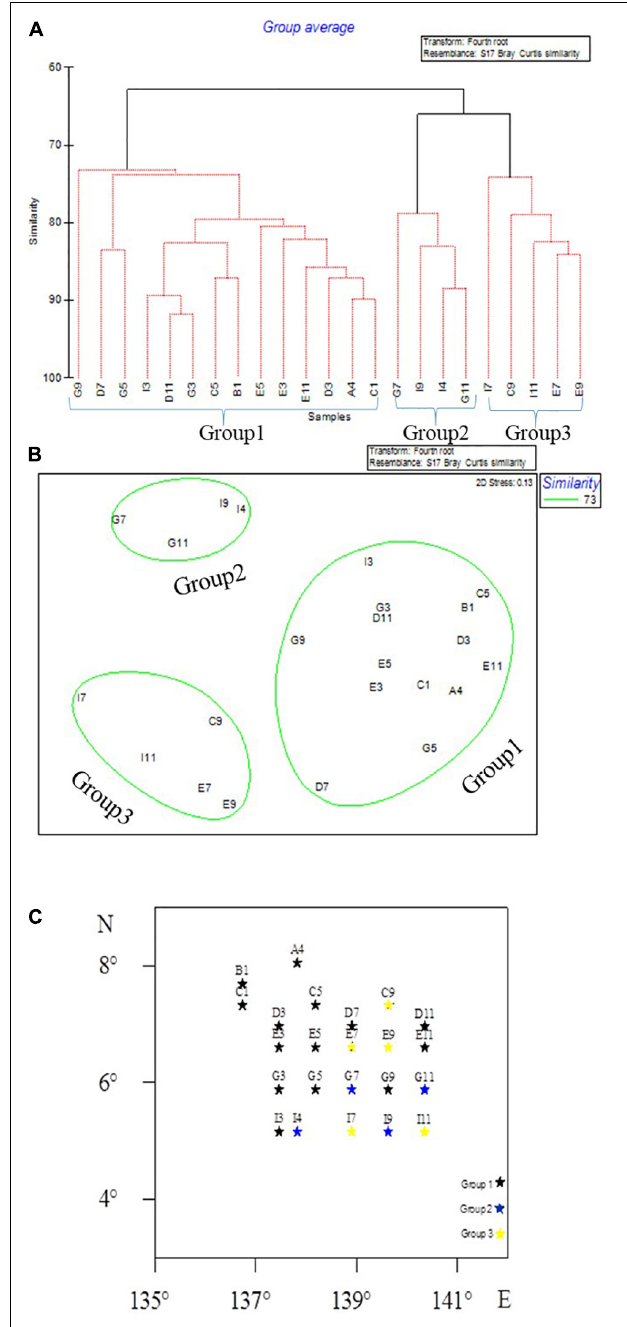
FIGURE 5 | Meiofaunal community groups in the Western Pacific Ocean as divided by CLUSTER analysis (A) , MDS ordination (B) , and as shown on the map (C) .